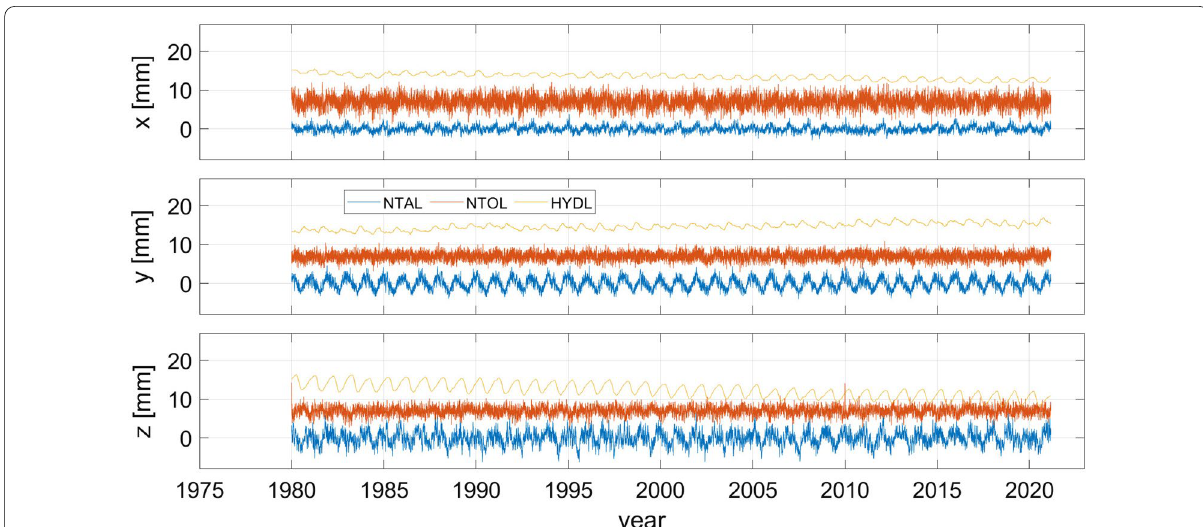
Fig. 7 Geocentre motion connected with the distinct non-tidal loading components of GCTI20. It is computed as the difference between the site displacements in the CF- and the CM-frame according to Eq. (2). The time-series for NTOL and HYDL have been shifted by 7 and 14 mm, respectively